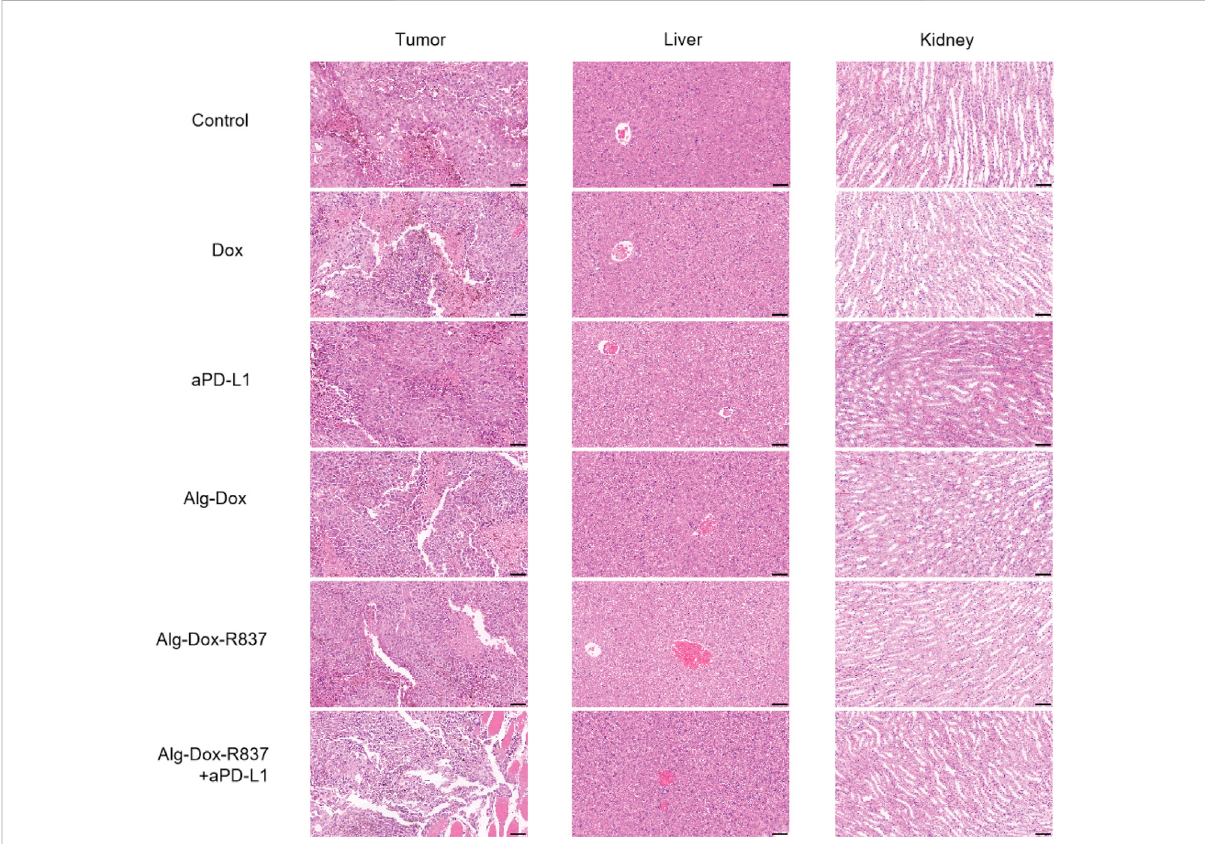
FIGURE 5 HE-stainedimagesofmajormetabolicorgans(liverandkidney)andtumortissueafter14 daysofdrugadministrationinmice(scalebar:50 μ